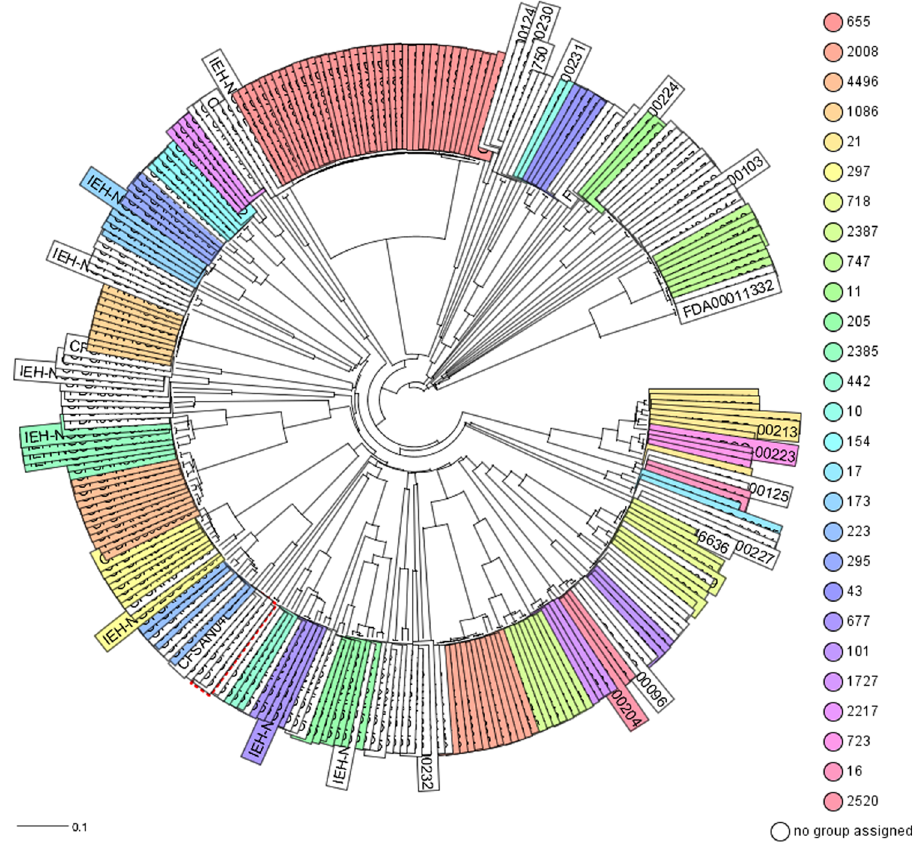
Fig 1. Phylogenetic relationships among the 276 STEC genomes of E . coli sequenced in this study by cgMLST analysis. Ridom SeqSphere+ (v5.0.0) identified 4,651core genes. The evolutionary history was inferred by using the Neighbor-joining (NJ) tree built using the genetic distance and showing the existence of many diverse clades with a complex evolutionary history. Strains are colored based on different STs as labeled.